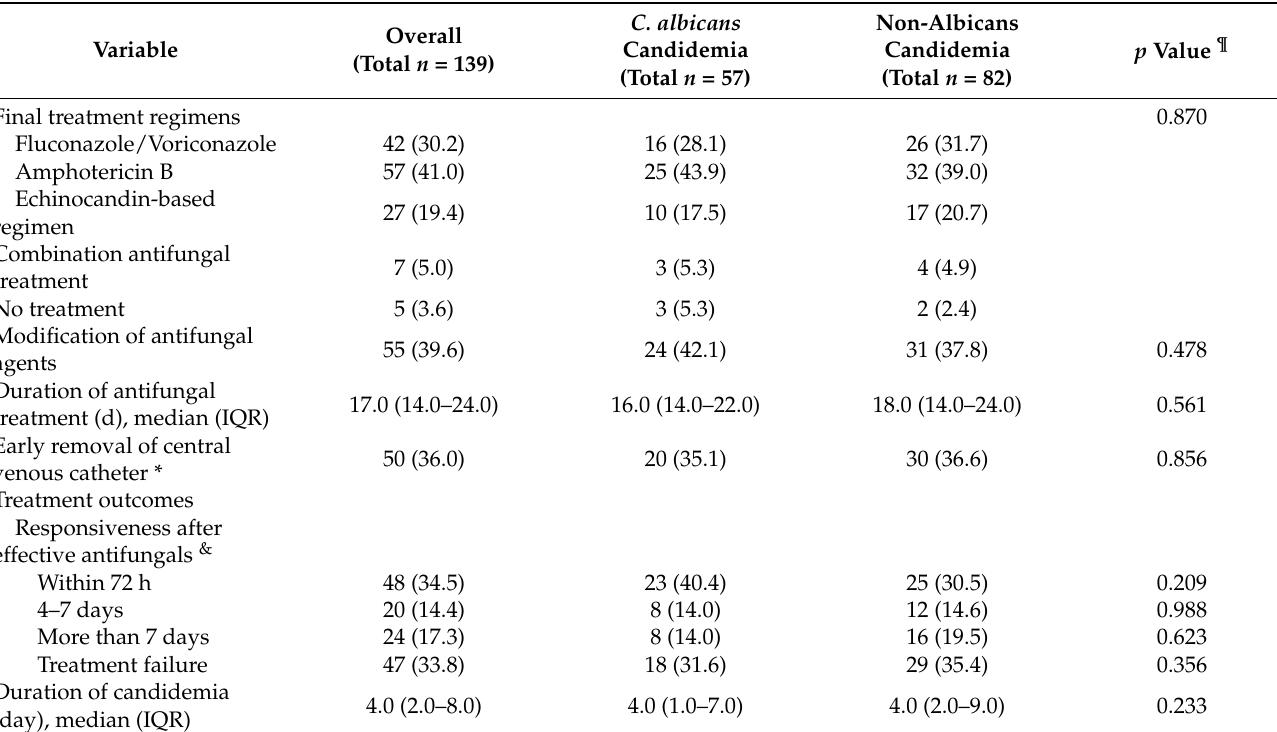
Table 3. Therapeutic strategies of neonatal candidemia and comparisons of the C. albicans candidemia versus non-albicans